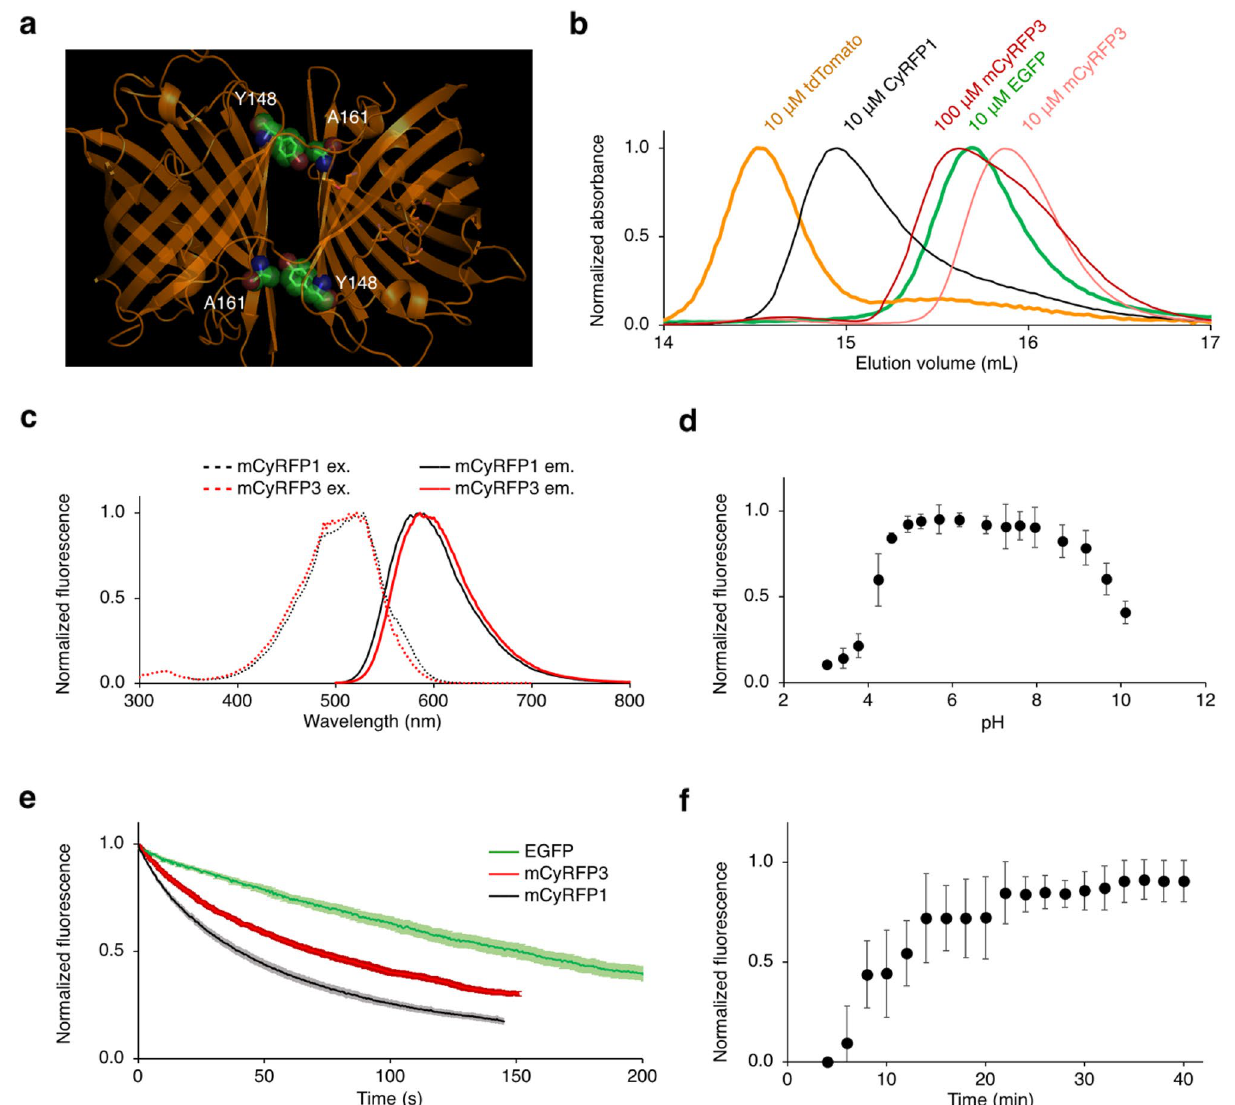
Figure 1. Engineering and characterization of mCyRFP3. Engineering of mCyRFP3. ( a ) Crystal structure of dimeric predecessor CyOFP1 displaying interacting residues Y148 and A161. Image was generated in Schrödinger MacPyMol 1.8. ( b ) Size-exclusion chromatography of EGFP, tdTomato, CyRFP1, and mCyRFP3. EGFP was used as a monomeric standard, while tdTomato was used as a dimeric standard. ( c ) Excitation and emission spectra of mCyRFP3 compared to its parent mCyRFP1. ( d ) pH dependence of mCyRFP3 fluorescence, demonstrating a pKa of 4.1. Error bars are s.em.m of triplicate measurements. ( e ) Photobleaching kinetics of purified cyan- excitable red fluorescent proteins under illumination by a 120-W metal-halide arc lamp through a 490/20-nm excitation filter. The time-axis was adjusted for each fluorophore to simulate excitation conditions producing 1000 photons per s per molecule. Lighter shading on CyRFP1, mCyRFP1, and mCyRFP3 lines represents standard deviation of five measurements. ( f ) Maturation kinetics of mCyRFP3 demonstrating a half- life of t = 12.5 min. Graphs in ( a ) through ( f ) were generated in Microsoft Excel for Mac